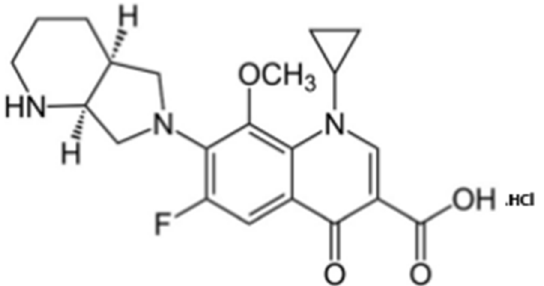
Figure 1. Chemical structure of moxifloxacin hydrochloride.